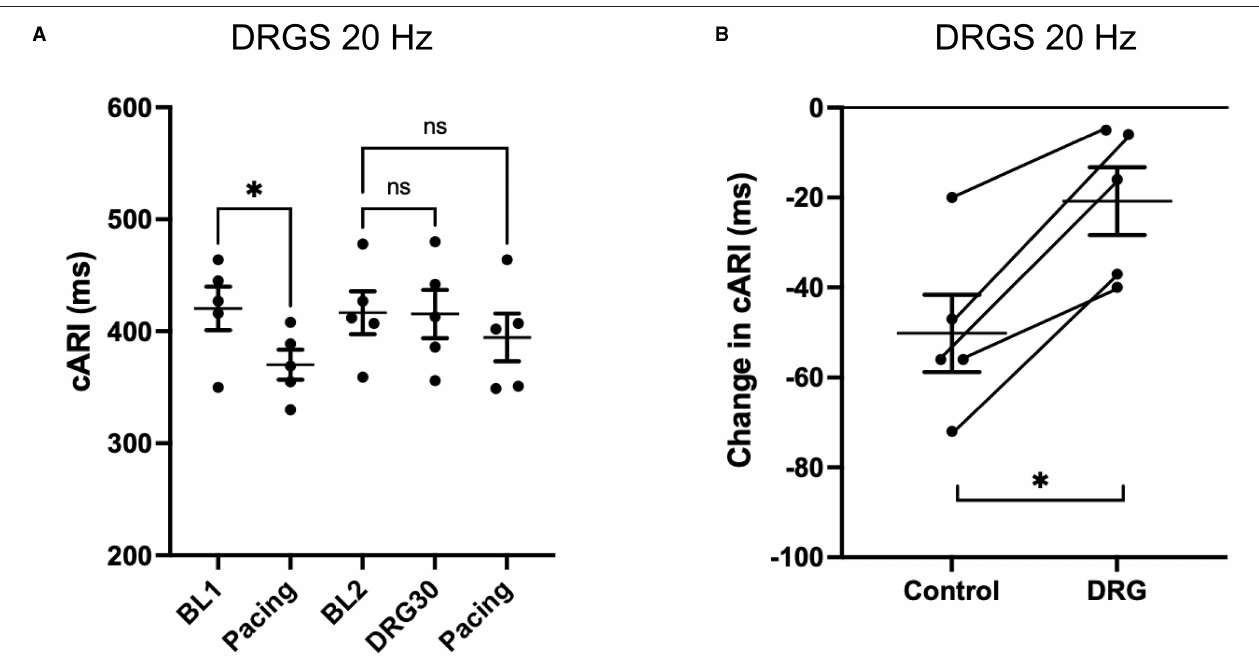
FIGURE 3 | Change in activation recovery interval (ARI) during the experiments with DRG stimulation at 20Hz. (A) Changes in ARI corrected by heart rate (cARI) during experimental protocol. Before DRG stimulation, cARI reduced after the pacing with significant difference ( * P = 0.414 from BL1), but there was no significant difference after DRG stimulation ( P = 0.586 from BL2). BL, baseline; S1S2 Pacing, 1min post-pacing before or after DRG stimulation; DRGS30, 30min after the initiation of DRG stimulation. (B) Reduction of cARI at 1min post-pacing from baseline or DRG30. DRG stimulation decreased the reduction of cARI with significant difference ( * P = 0.007). Data are reported as mean ± standard error